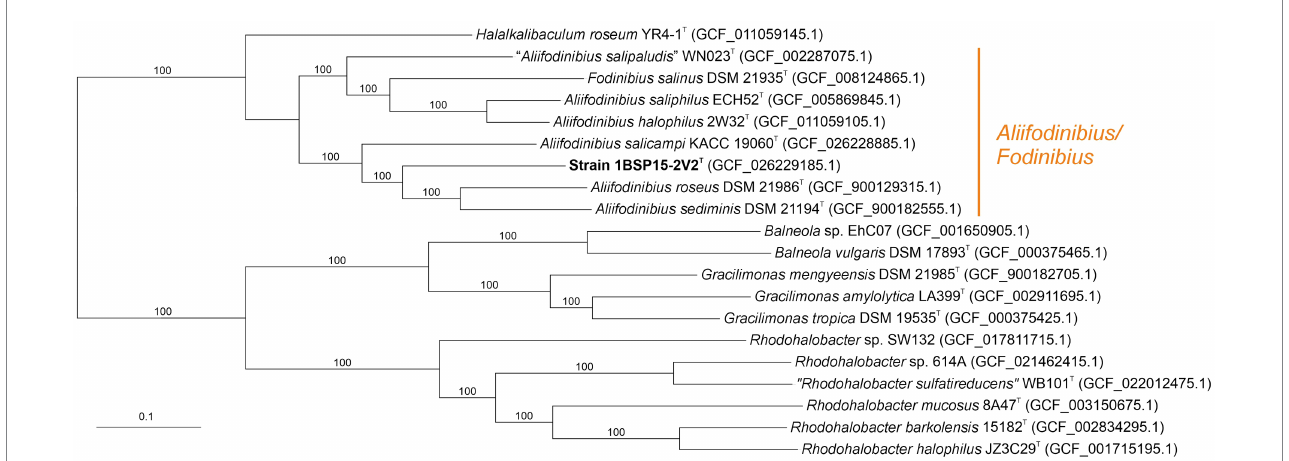
FIGURE 3 Approximately maximum-likelihood phylogenomic tree based on 1,049 concatenated core protein sequences of members of the family Balneolaceae . Bootstrap values ≥ 70% are indicated above the branches. Bar, 0.1 substitutions per nucleotide position.